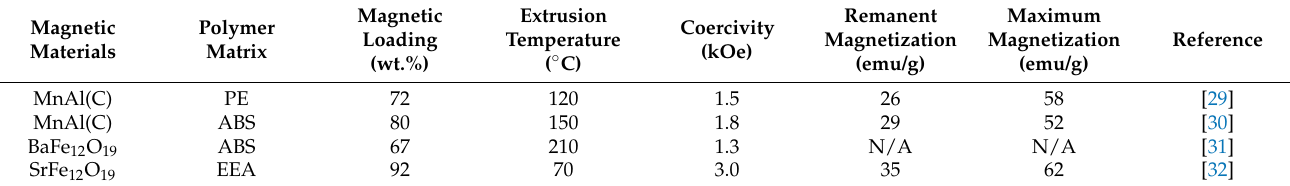
Table 2. Properties of magnetic filaments for fused filament